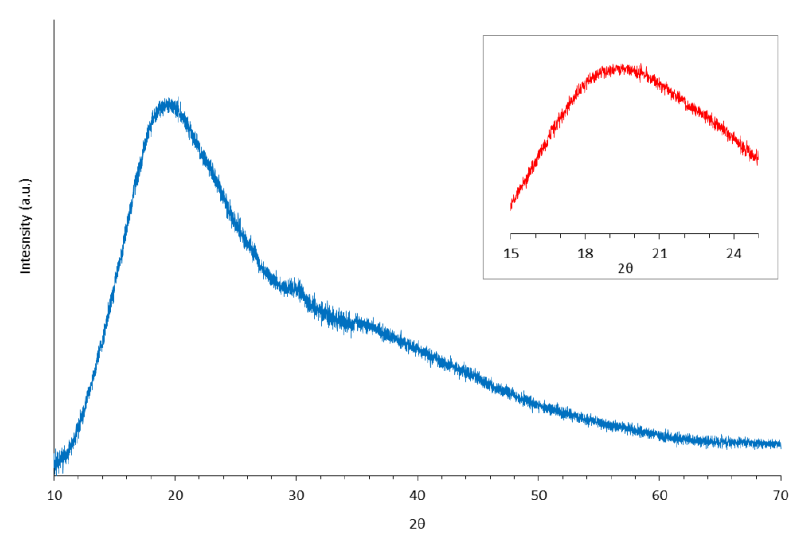
Figure 8. X-ray diffraction pattern of EPS produced by cultivation of B. atrophaeus BU4 in a glucose- based synthetic medium (SM-G15). The insert shows a magnification of the area around the peak